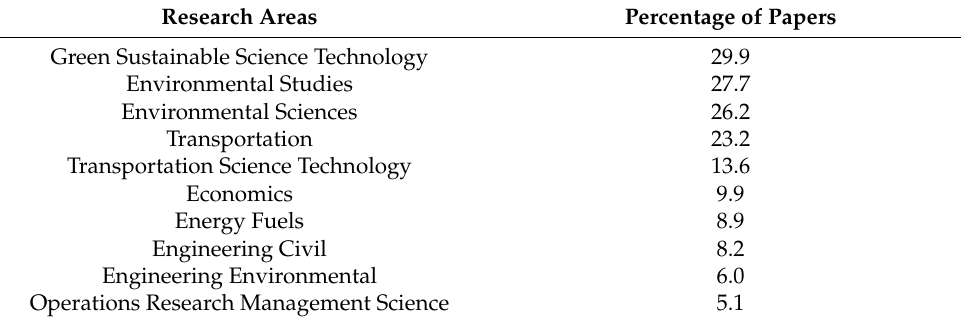
Table 1. Top ten research areas in sustainability transport.